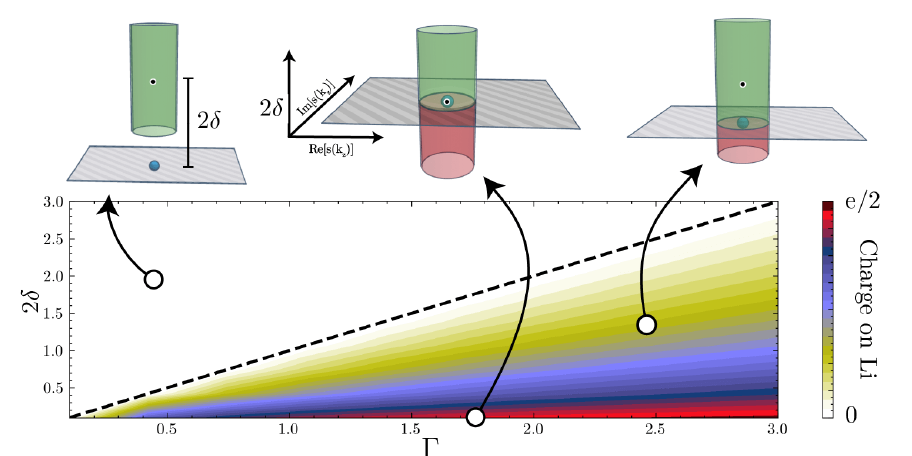
Figure 3: Surface charge density per Li (color map) calculated within the full TB model and cylinder